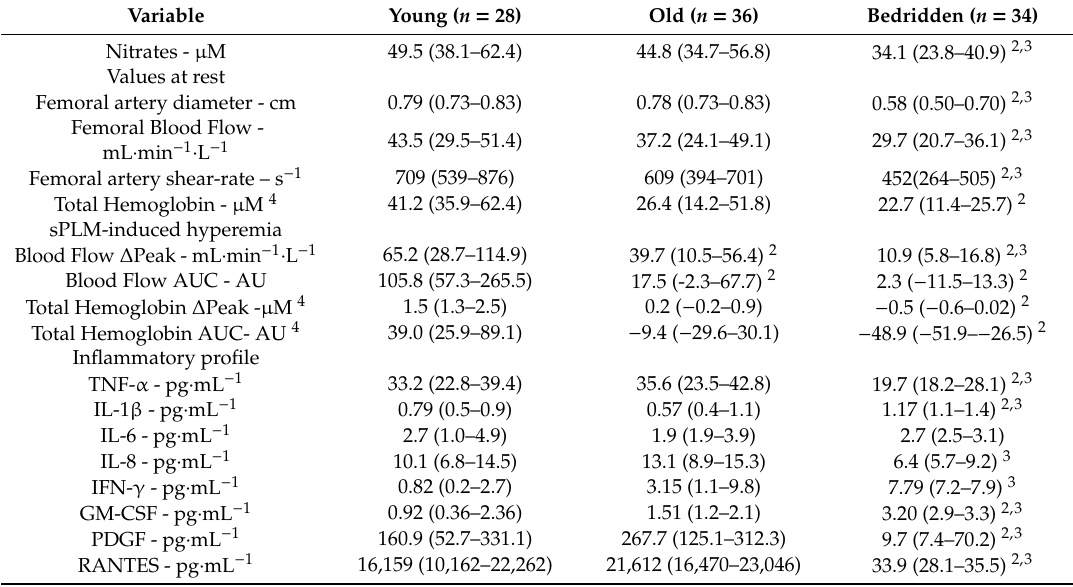
Table 2. Comparison between groups: Young, Old, and Bedridden 1 .